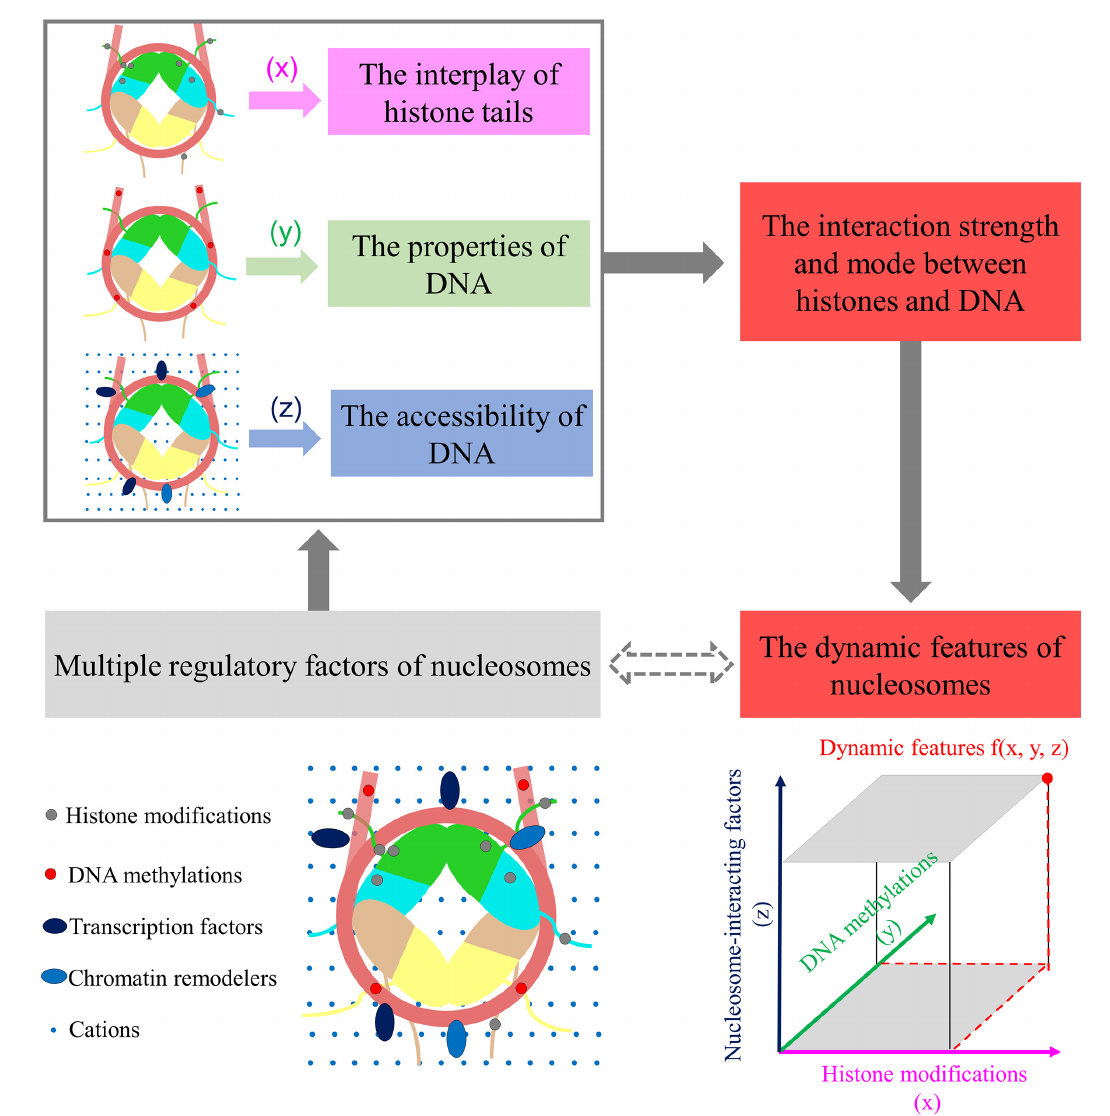
Figure 2. The main regulatory mechanism of nucleosome dynamics by the impact of different regulatory factors. The regulatory factors consist of histone modifications (x), DNA methylation (y), and nucleosome-interacting factors (z), including transcription factors, chromatin remodelers, and cations. Three regulatory factors are shown in colored blocks and distributed in different locations on nucleosomes. The dynamic features of nucleosomes are regulated comprehensively by the impact of histone modifications (x), DNA methylation (y), and nucleosome-interacting factors (z), and the effect of the dynamic features is depicted as f(x, y, z). The arrow icon in solid line represents the current strategies for the mechanism research of nucleosomes, while the arrow icon in dash line represents the possible strategies for the mechanism research of nucleosomes in future.